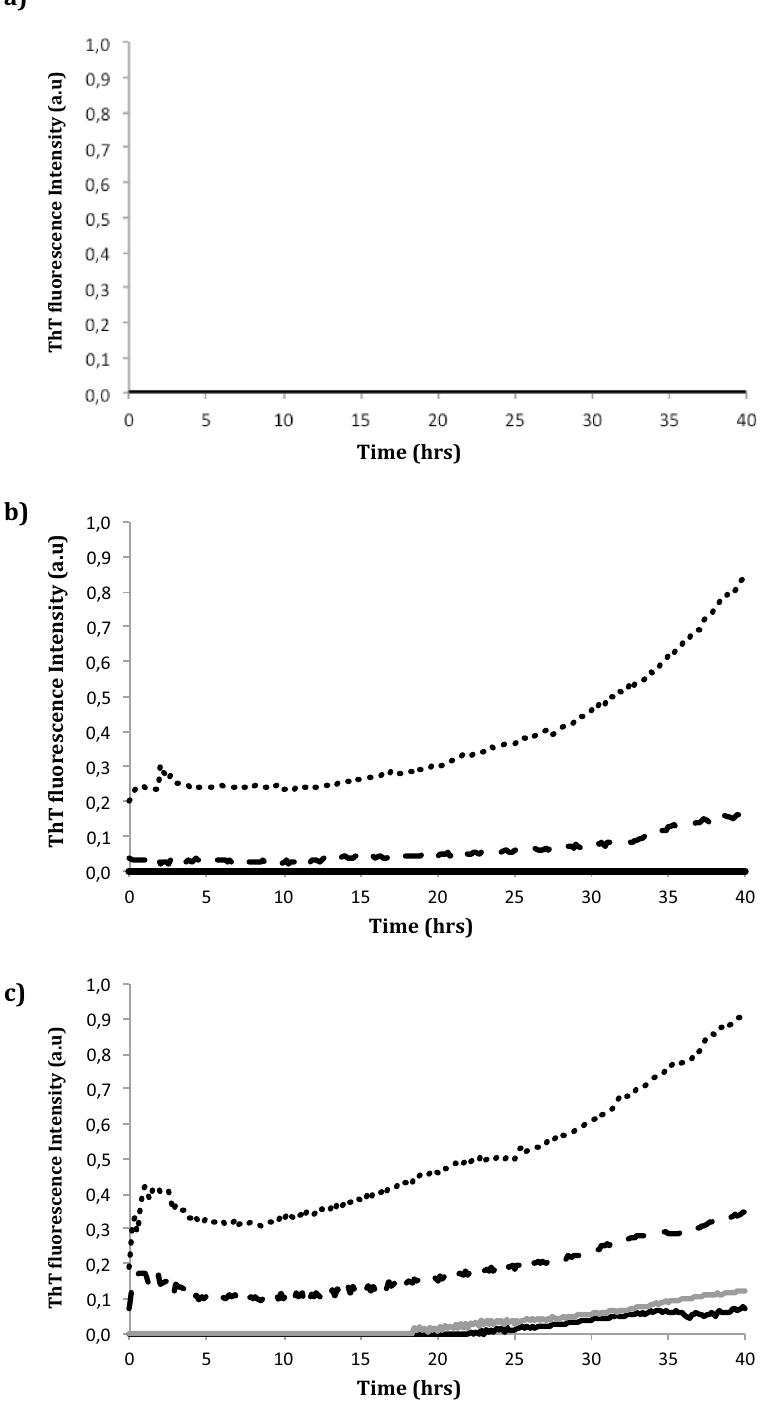
Figure 1. Kinetics of formation of ERα17p amyloid fibrils by ThT fluorescence spectroscopy, at various peptide concentrations (in μM) and pH values. Experiments are tested in water at four peptide concentrations, i.e. at 10 (black curve), 25 (grey curve), 50 (black dashed line) and 100 μM (black dotted lines), in the presence of ThT 10 μM. ( a ) pH 3.4 (0.2 M glycine HCl in water), ( b ) pH 7.4 (0.2 M KH 2 PO 4 /0.2 M K 2 HPO 4 in water) and ( c ) pH 9.1 (0.2 M glycine NaOH in water). Excitation and emission wavelengths are 440 and 485 nm, respectively. Fluorescence intensity is expressed in arbitrary units (a.u.) and time in hours. Data are the means of experiments performed in triplicate. Each experiment is carried out over 40